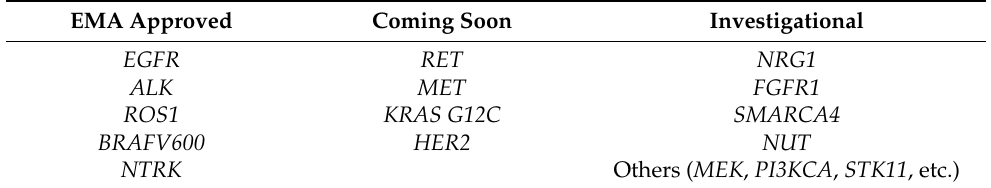
Table 1. Current recommended, coming soon, and potential future genomic biomarkers to be looked for at baseline in non-squamous non-small-cell